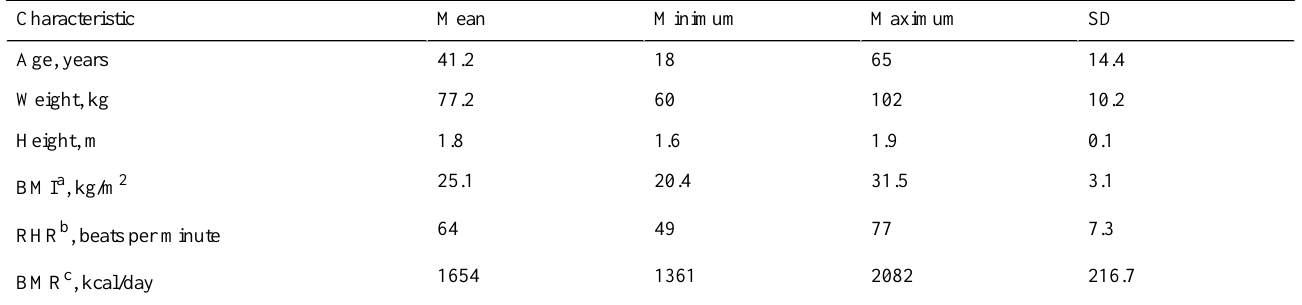
Table 3. Overview of participants’(averaged) demographic